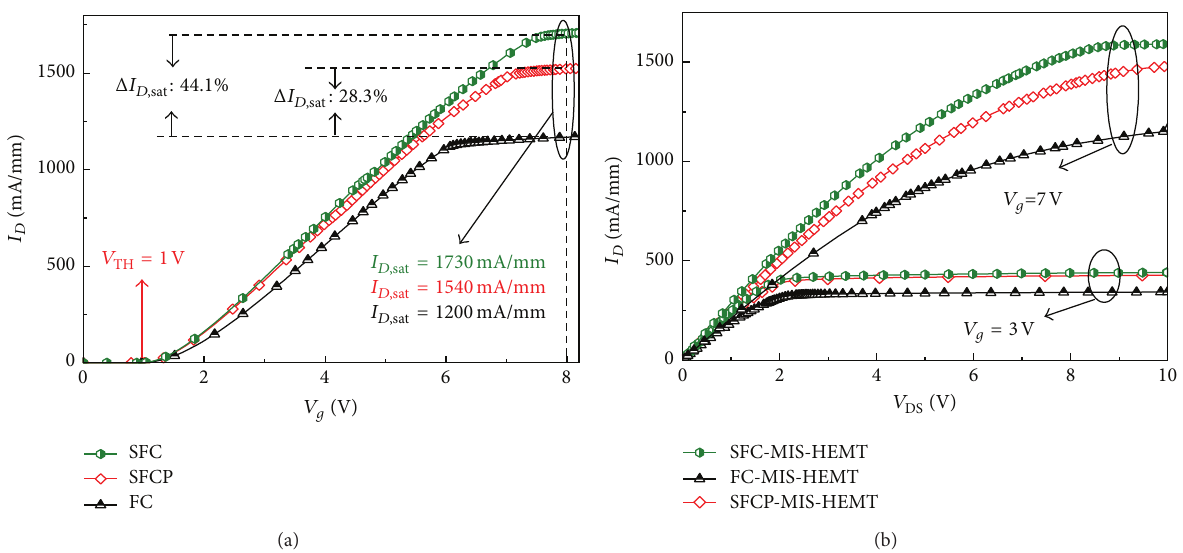
Figure 6: (a) Transfer characteristic curves at 𝑉